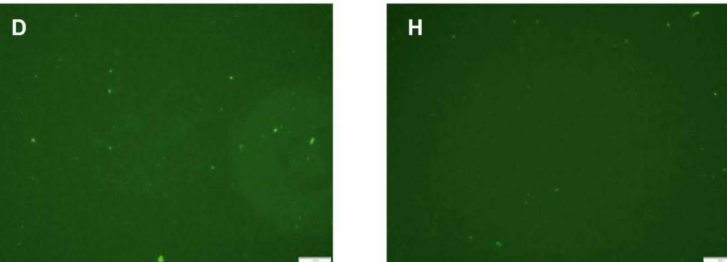
Figure 3. Morphology of ADMSCs adhering to native ( A – C ) and oxidized ( E – G ) FITC-Col I. The cells were stained for actin (red) and nuclei (blue), and viewed with the underlying fluorescent substratum (green). ( A , E ) present the overall morphology of cells adhering on native and oxidized collagen, respectively. ( B , F ) present the underlying substrates of the same samples with artificially superimposed cell contours and nucleus. In ( C , G ), the cell shapes are omitted. ( D , H ) show the native and oxidized collagen substrates, respectively, with no cells added. The yellow arrows point to typical fibrillary collagen arrangements beneath the cells, while the white arrows point to arrangements outside of the cells along the cells’ periphery. Scalebar 20 µ